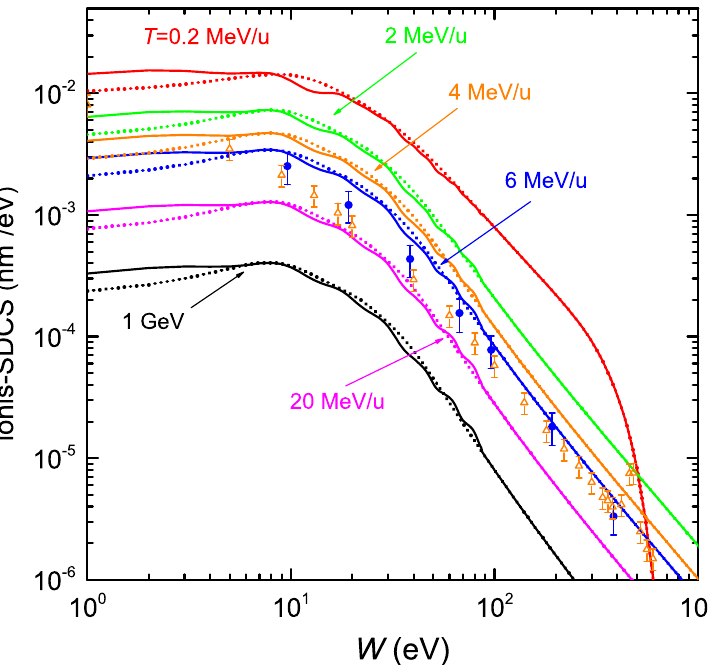
Figure 4. Energy distributions (ionis-SDCS) of emitted electrons as a function of the ejected kinetic energy W , for several carbon incident energies T . Solid (dotted) lines correspond to our calculations for liquid water using the LR-TDDFT (MELF-GOS) approach. Symbols are experimental data for water vapour coming from Ref. [26] (6 MeV/u carbon ions, full circles) and from Ref. [102] (4 MeV/u carbon ions, open